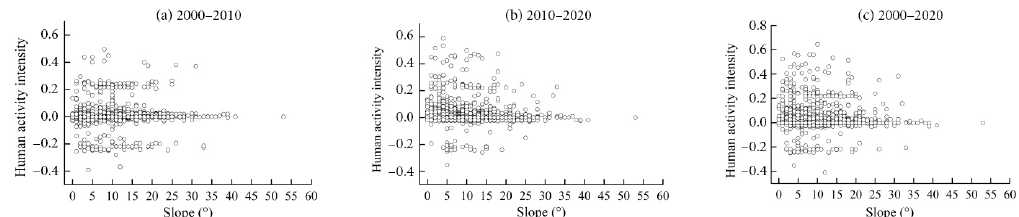
Figure 7. Changes of human activity intensity function of the slope at the pixel scale in Guiyang